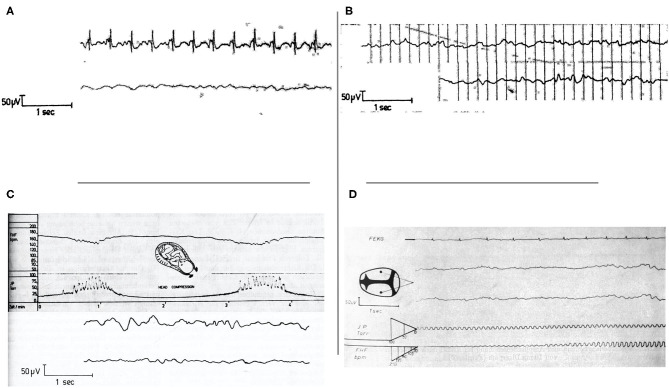
(A) Simultaneous recording of fECG and fEEG. Artifacts from fECG effect on fEEG can be identified by recording both traces simultaneously. From Hopp et al. (44). (B) Intra and post-partum fetal/neonatal EEG recordings showing the great similarity between both traces. From Hopp et al. (44). EEG, electroencephalogram. (C) Cardiotocogram (top) and fEEG (bottom) recorded during early cardiac deceleration. The fEEG pattern represents the change during contractions with high amplitude low-frequency waves and the recovery once the contractions ceased. From Hopp et al. (44). fEEG, fetal electroencephalogram. (D) Simultaneous recording of fECG (top trace), two-channel fEEG (middle two traces), and FHR (bottom trace). This figure shows fEEG changes during severe variable deceleration. The fEEG trace shows waves of low amplitude and near isoelectricity as well as intermittent spike potentials between contractions. From Hopp et al. (30). fECG, fetal electrocardiogram; fEEG, fetal electroencephalogram; FHR, fetal heart rate.